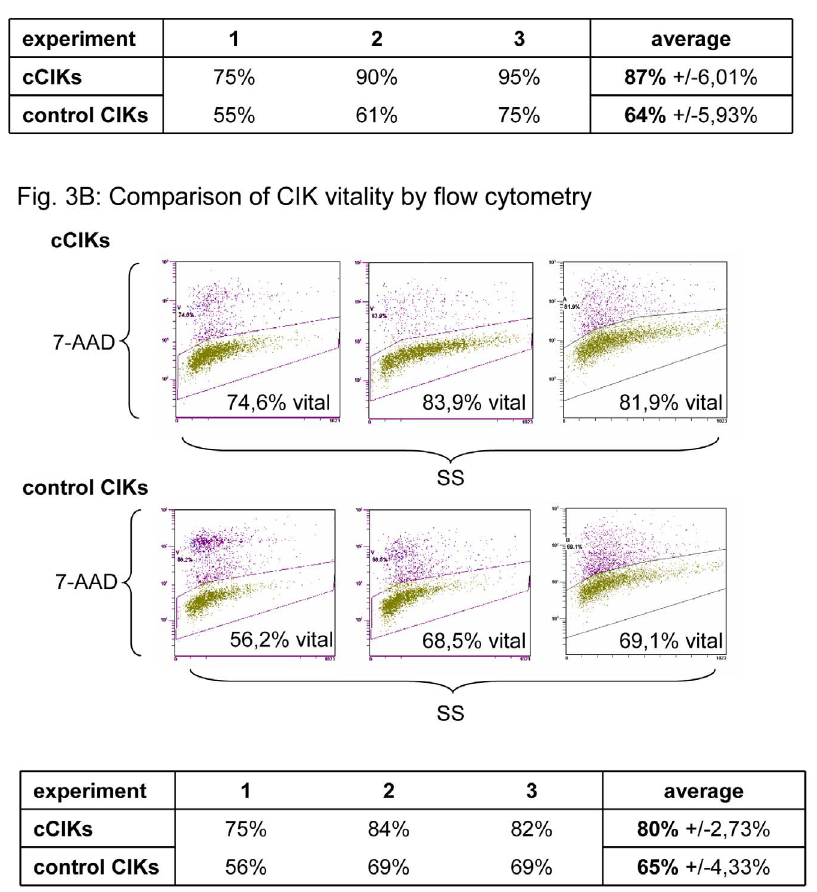
Figure 3. Comparison of CIK vitality. Vitalities of control CIKs and cCIKs were assessed on day 14 using two different methods. Part A displays vitalities determined using trypan blue staining. No significant differences in CIK viability were found at the 0.05 level (p=0.1). Part B shows comparisons of CIK vitality, as assessed using 7-AAD staining. No significant differences were found (p=0.1).